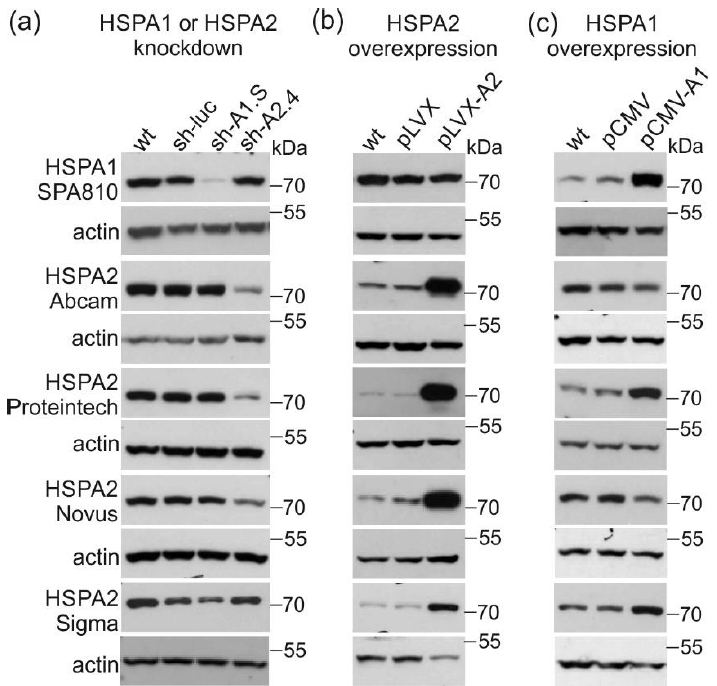
Figure 2. Western blot detection of endogenous HSPA2 in NCI-H1299 cells using commercial